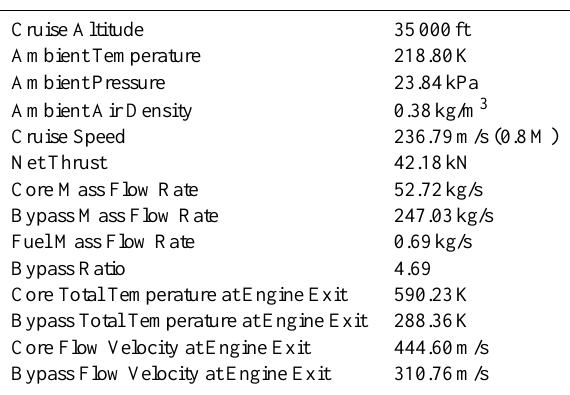
Table 1. Parameters used for the microphysical parcel simulations in this work.